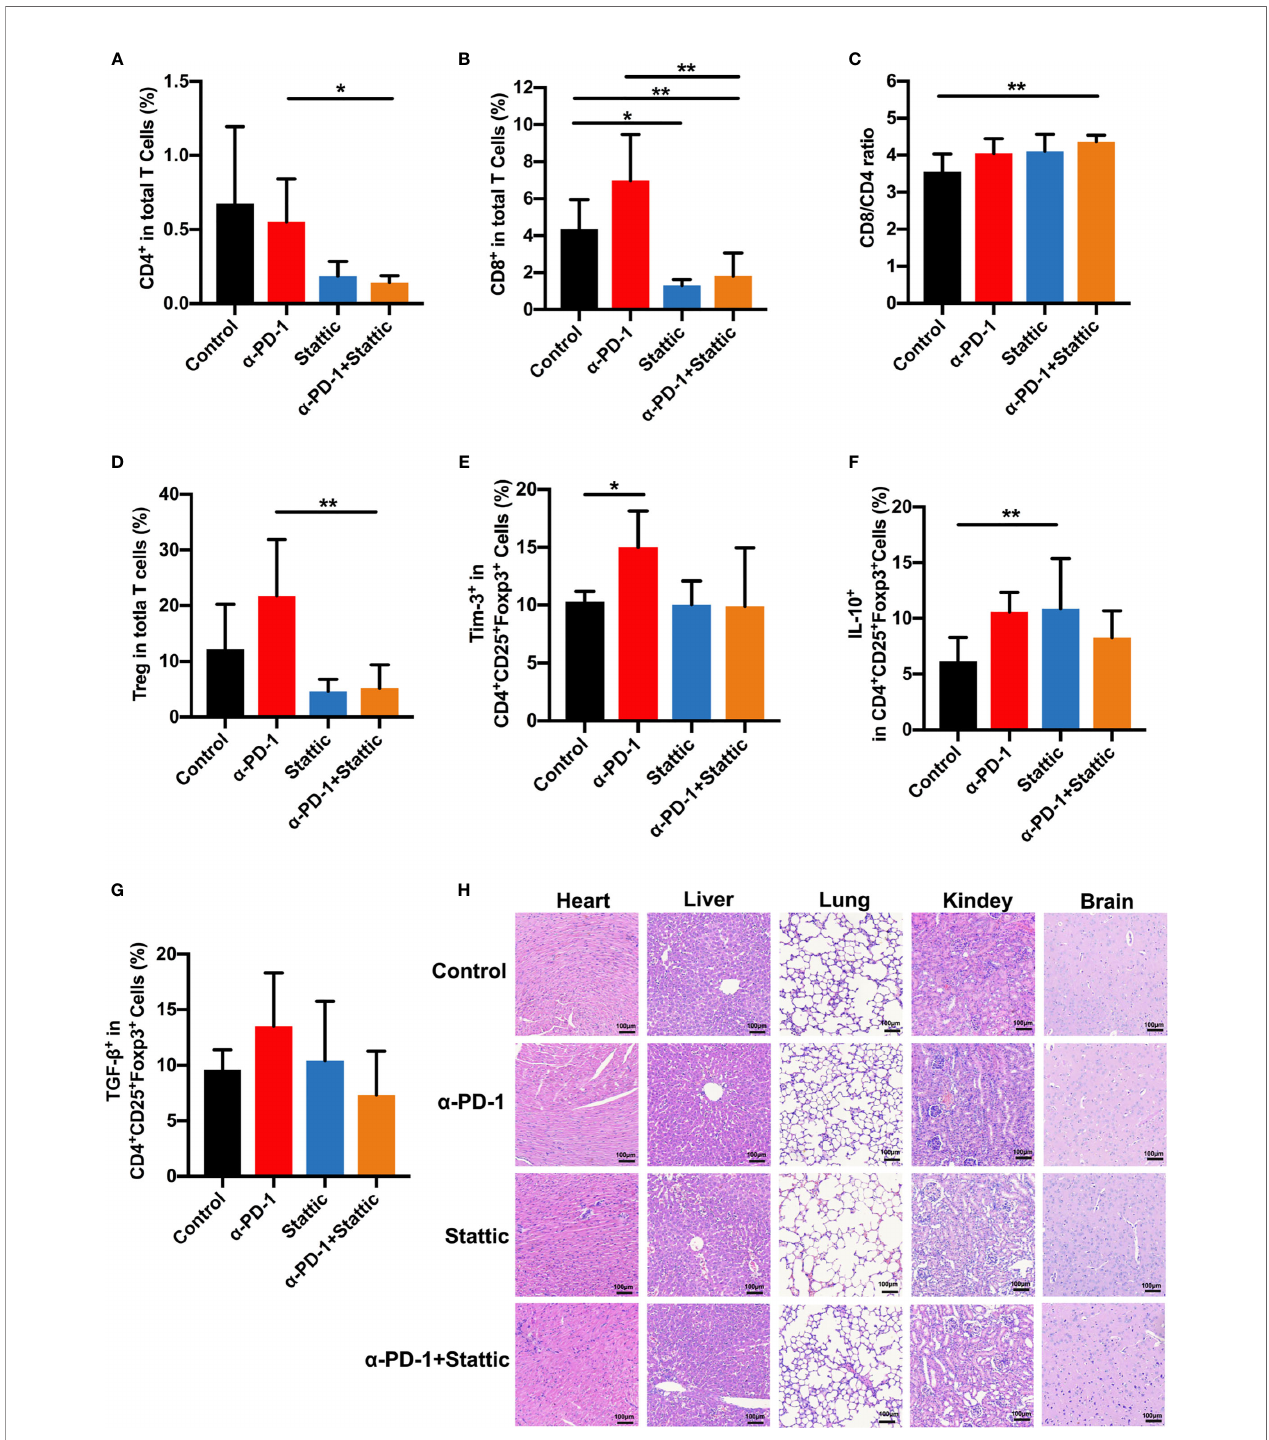
FIGURE 6 | STAT3 downregulation promotes antitumor immune response. (A – C) Analysis of intratumoral CD4 + and CD8 + T cells in melanoma models. The proportion of intratumoral CD4 (A) cells and CD8 (B) T cells and CD8 + /CD4 + T cells ratio (C) in response to anti-PD-1 in comparison to anti-PD-1 and Stattic, Stattic, and control groups. (D) Percentages of CD4 + CD25 + Foxp3 + Treg cells among total cells in melanoma (n=5). (E – G) percentage of positive Tim-3 expression (E) , IL-10 (F) and TGF- b (G) production in Treg cells after different treatment in a mouse model. (H) Systematic toxicity of anti-PD-1 and Stattic in melanoma models. Organ toxicity was assessed by H&E staining. Scale bar = 100 m m. * p ≤ 0.05 and ** p ≤